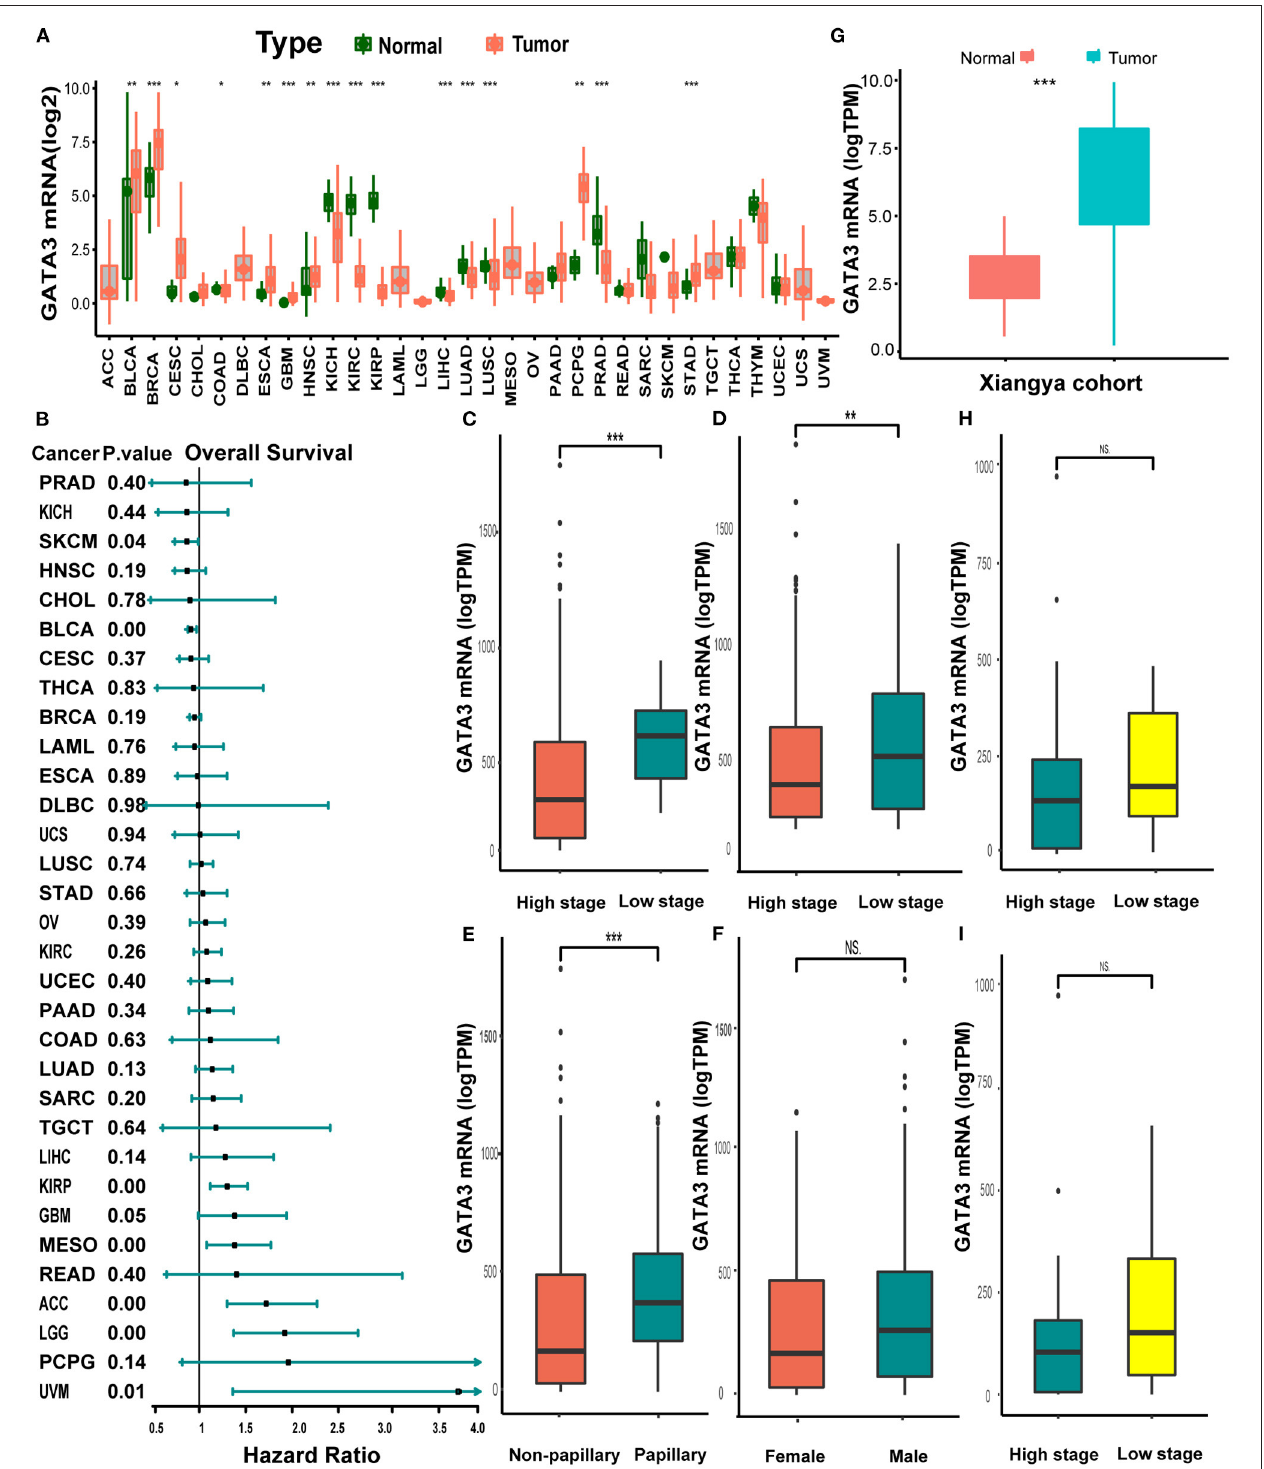
FIGURE 1 | Pan-cancer expression profiles and prognostic significance of GATA3. (A) GATA3 expression between normal tissues and tumor tissues in 33 various cancers. (B) Hazard ratios of overall survival analysis in various cancers with univariate cox analysis. (C–F) Clinicopathological correlation analysis of GATA3 in the TCGA-BLCA cohort. (The analysis was done using the T -test. * P < 0.05, ** represented a P < 0.01, *** represented a P < 0.001, and NS signified a P > 0.05). (G) Expression analysis of GATA3 in the Xiangya-Pingkuang cohort. (H,I) . Correlation analysis of clinicopathological characteristics of GATA3 in the Xiangya-Pingkuang